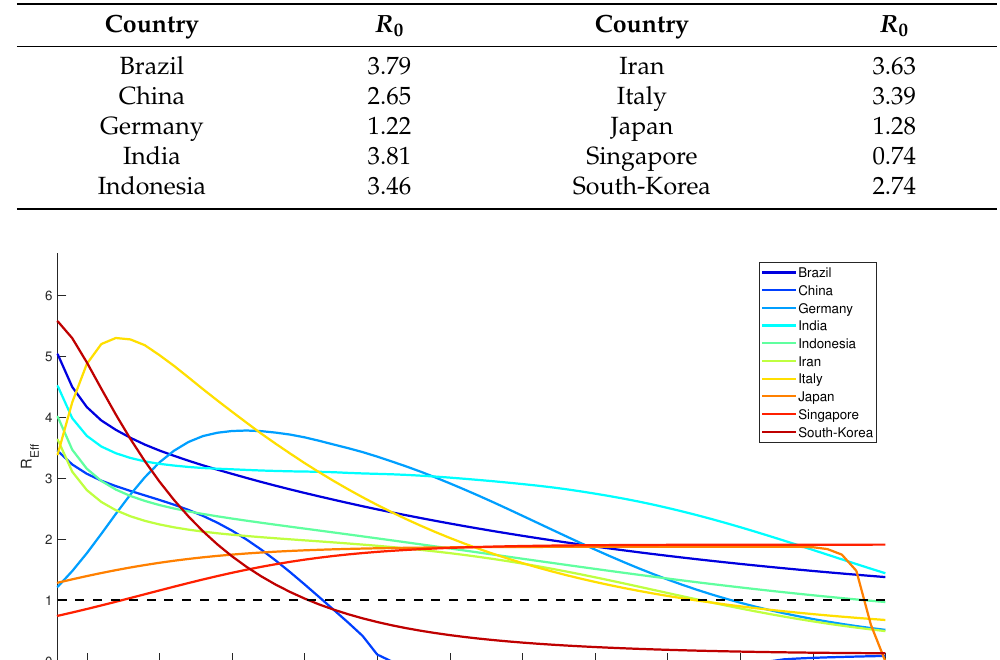
Table 3. Estimated basic reproduction number R 0 for the simple model.